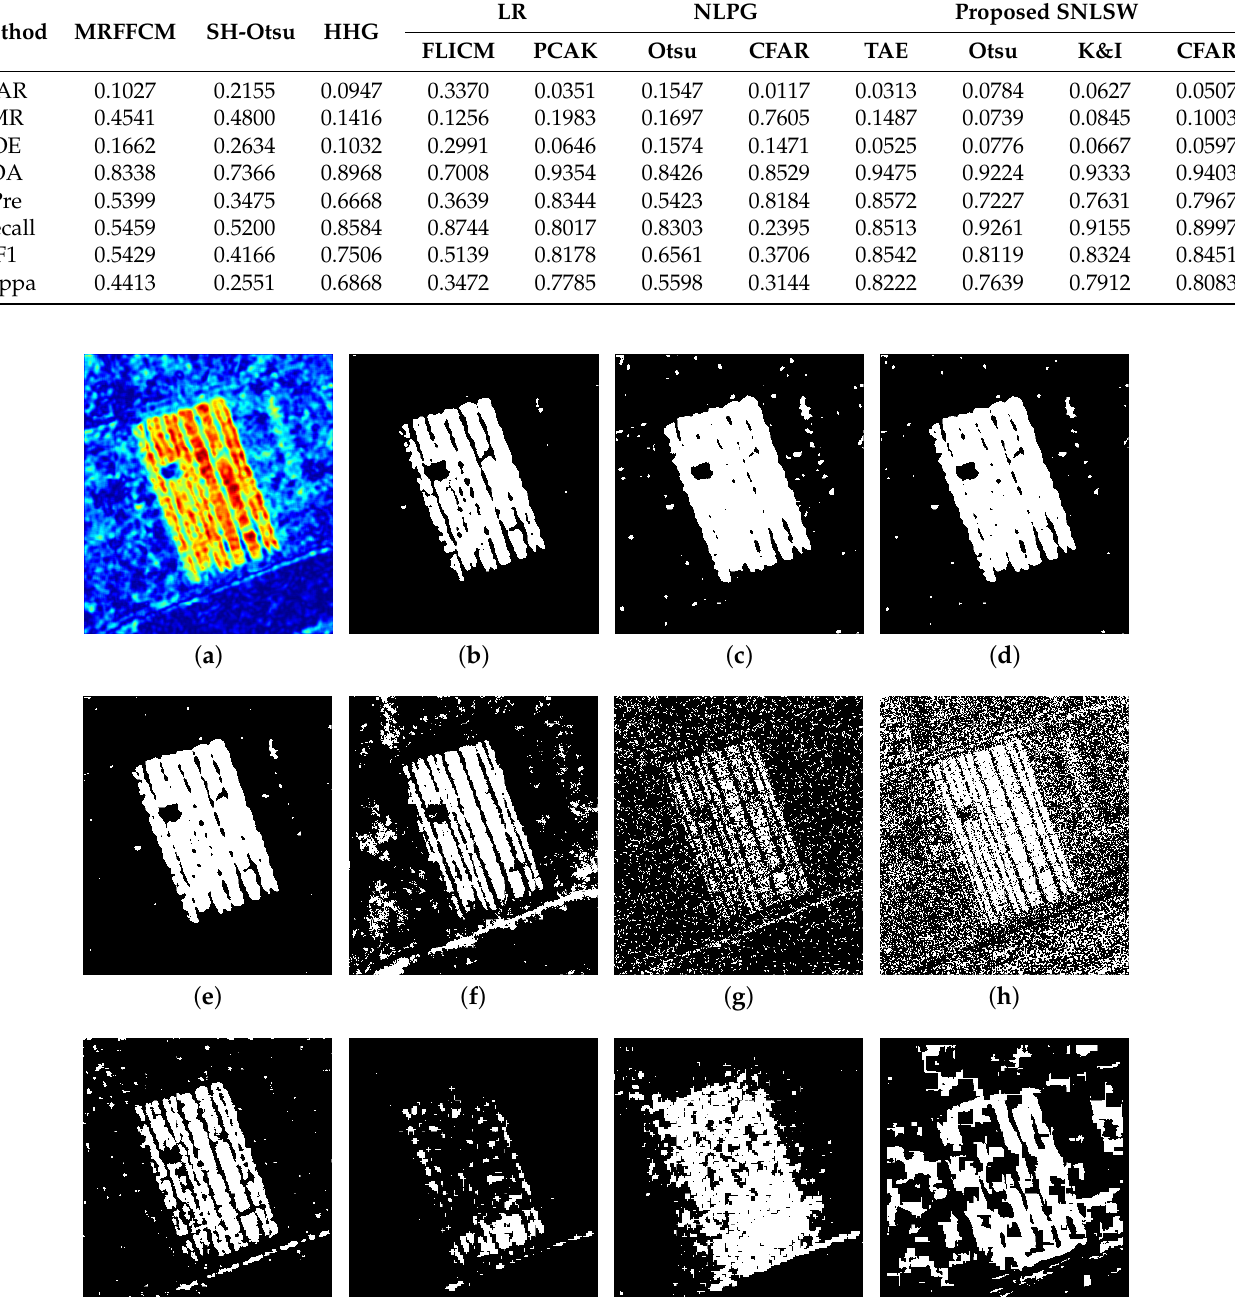
Table 1. Quantitative evaluation of the different methods on Dataset #1.